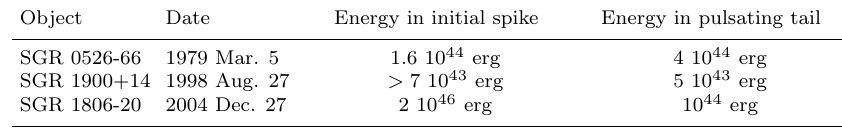
Table 1. Three giant (cid:13)ares from Soft Gamma Repeaters.